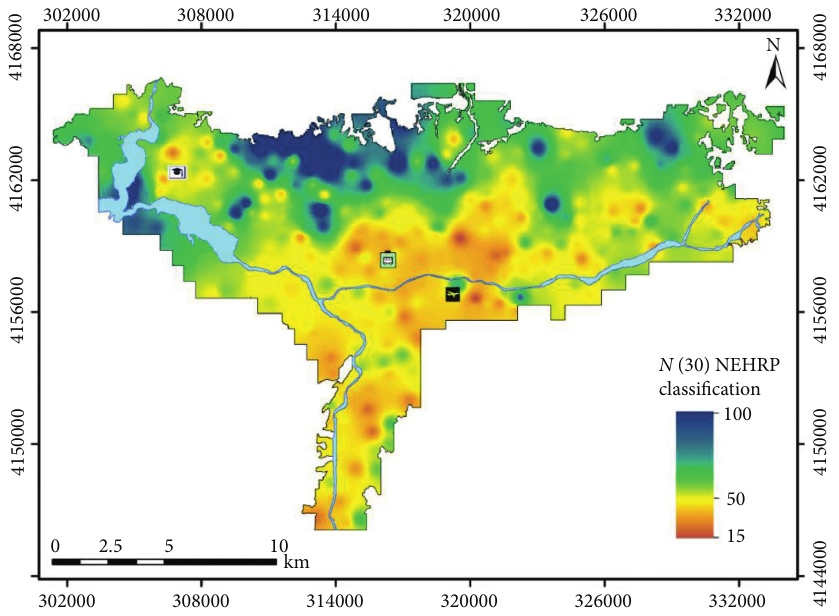
Figure 8: N 30 based seismic site classification map in Kahramanmaras